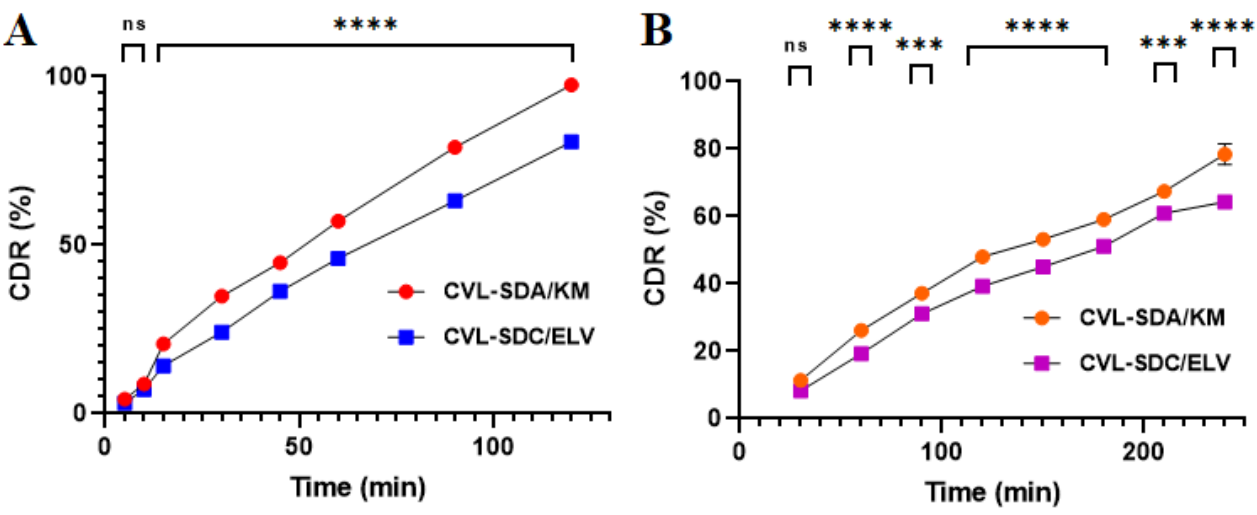
Figure 6. In vitro release profiles of CVL-SDs in ( A ) FaSSGF pH 1.2 and ( B ) FaSSIF pH 6.8 (data expressed as the mean ± SD, n = 3; ns—non-significant, * p < 0.05, ** p < 0.01, *** p < 0.001, **** p <